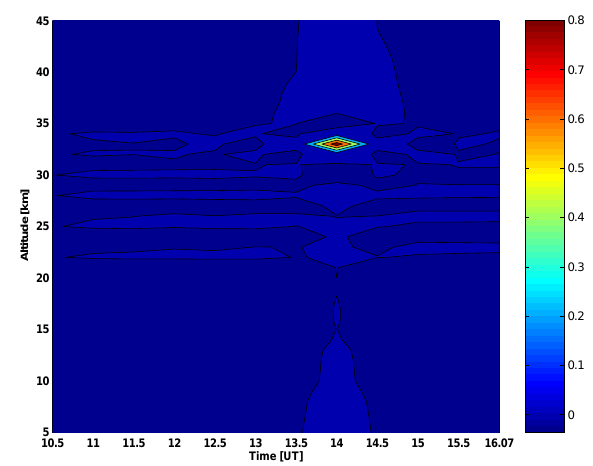
Fig. 4. Number of degrees of freedom of the retrieval (trace of the averaging kernels matrix A) plotted as a function of the half width at half maximum h . This curve applies to the retrieval of NO 2 profiles from limb scanning measurements.